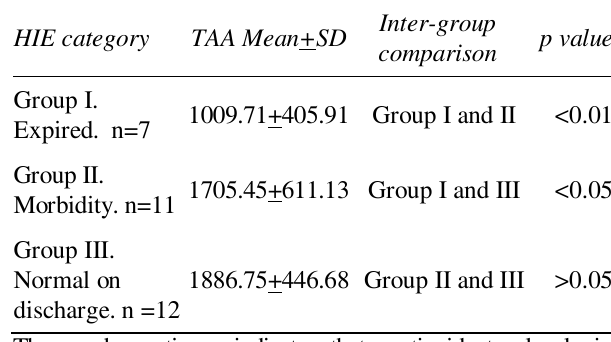
Table 3: Total antioxidant level (µmol/L) in hypoxic ischemic encephalopathy (HIE) with poor outcome.